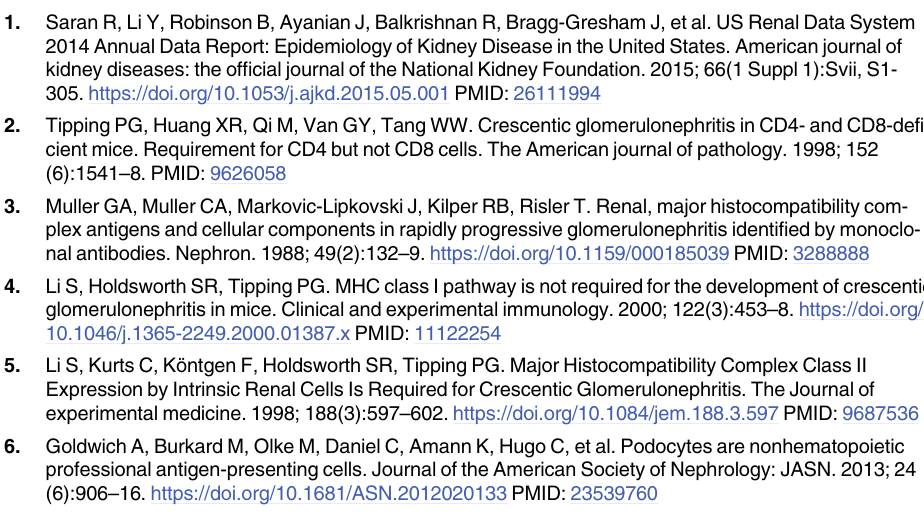
S1 Fig. IL-2 assay using splenocytes as antigen presenting cells. There is no T cell production of IL-2 when splenocytes are treated with media or IgG alone but there is a significant increase in IL-2 production when splenocytes are incubated wth immune complexes (IgG + Ova). a, p < 0.001. S2 Fig. Histologic analysis of control and podocyte FcRn KO mice injected with IgG con- trol and saline. There was no difference in glomerulosclerosis scores between control mice and podocyte FcRn KO mice injected with saline (sal) nor with control IgG (IgG). n = 2 mice per group. Scale bars in lower left corner are 20 μ